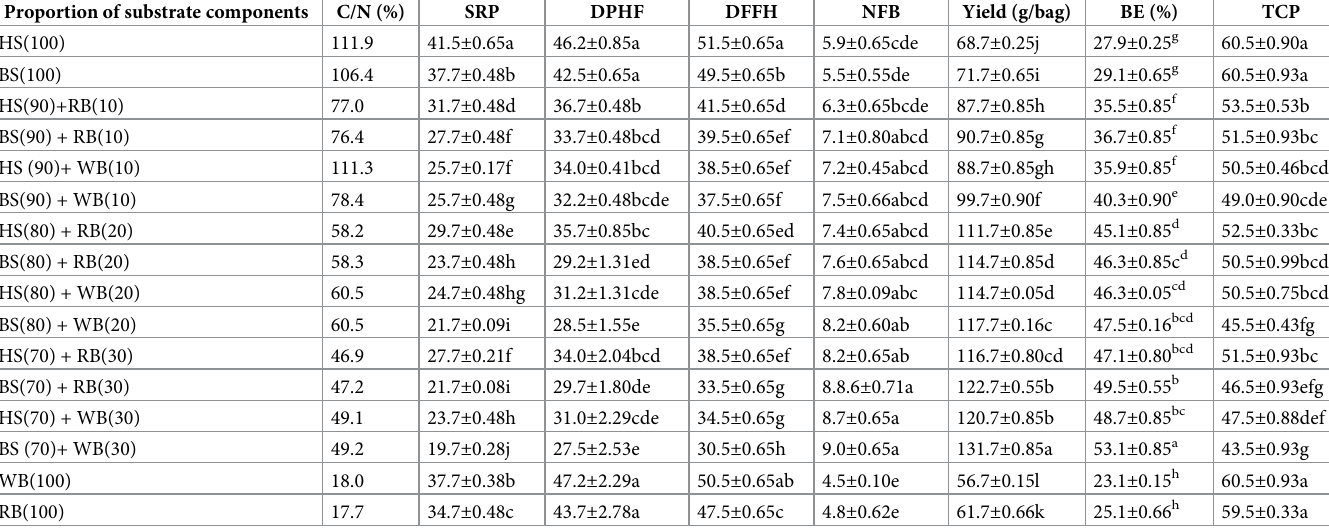
Table 3. Effects of different substrate obtained from different concentration levels (%) of beech (BS) and hornbeam sawdust (HS) wheat (WB) and rice brans (RB) on yield, biological efficiency (BE), spawn run period (SRP), days for pinhead formation (DPHF), days for the first harvest (DFFH), number of fruiting body (NFB) and total cultivation period (TCP) of Auricularia cornea . Proportion of substrate